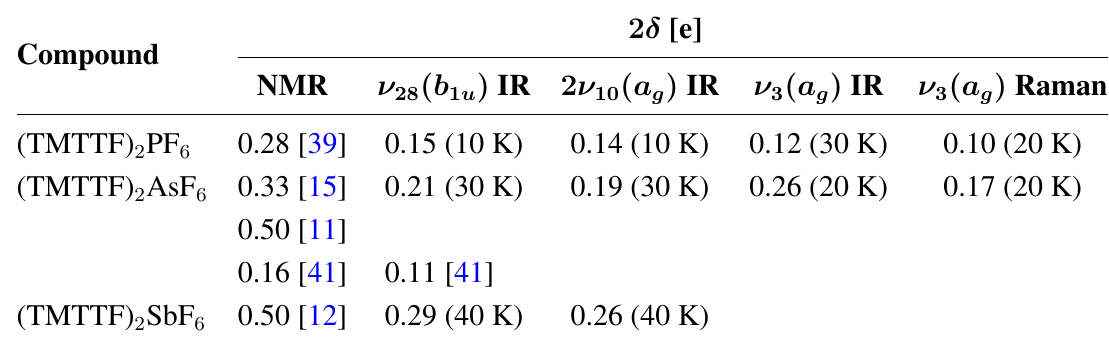
Table 3. The charge disproportionation 2 δ is defined as the difference between charge